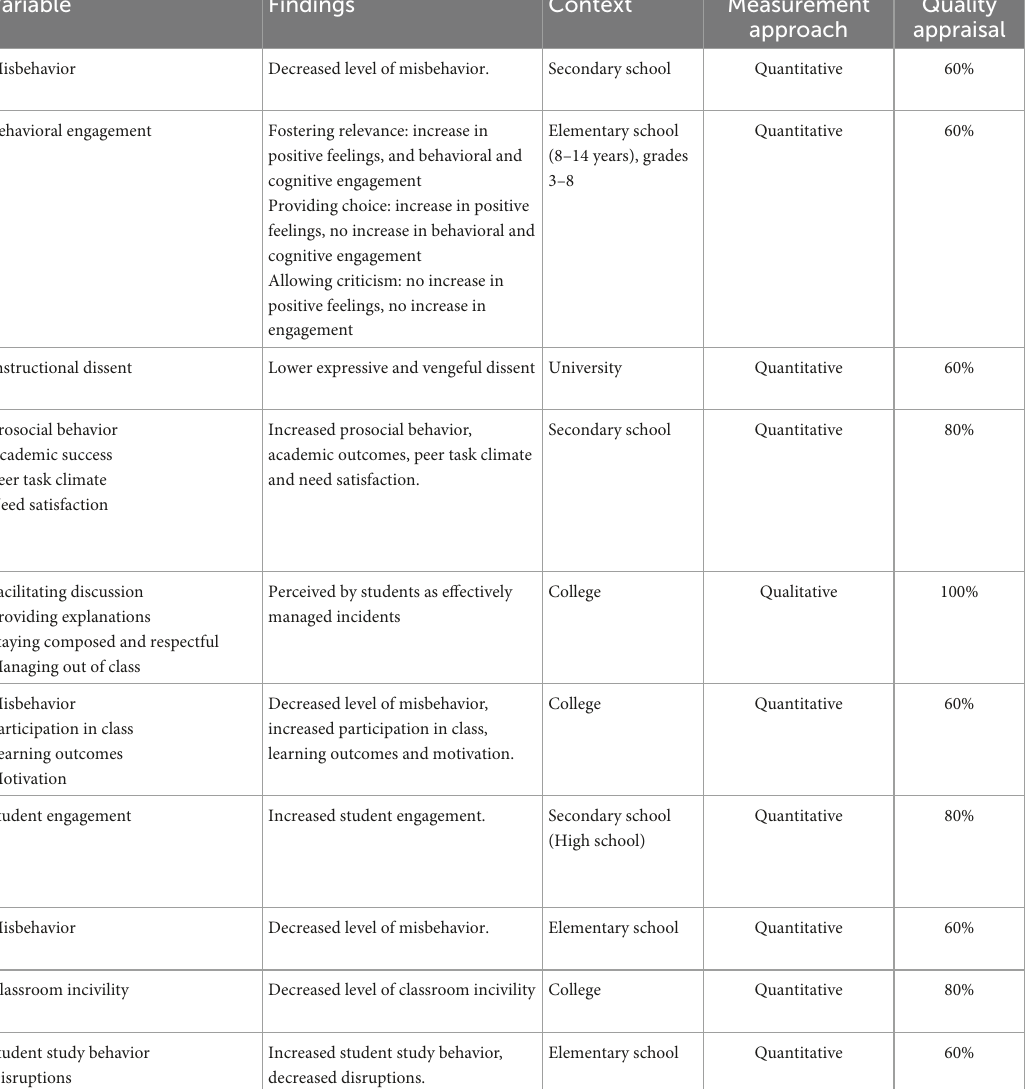
TABLE 1 Overview of the reviewed studies.